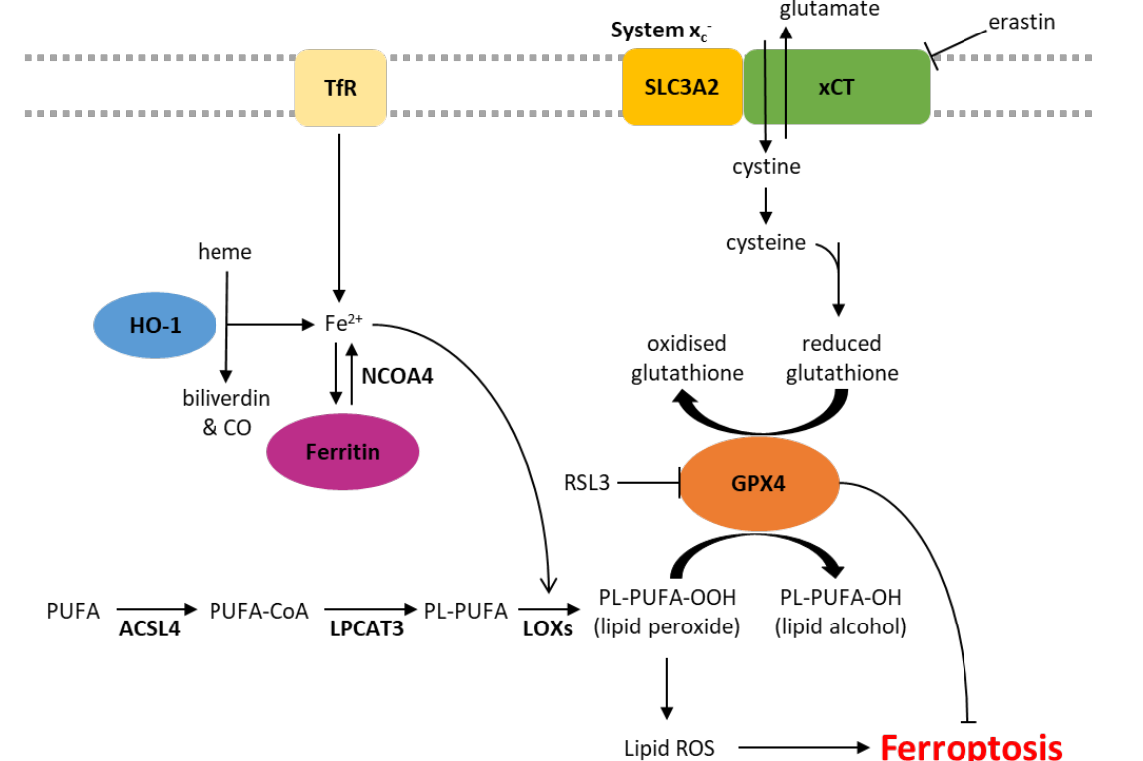
Figure 1. Biochemical pathways involved in the regulation of ferroptosis. ACSL4, acyl-CoA synthe- tase long-chain family member 4; CO, carbon monoxide; Fe 2+ , ferrous iron; GPX4, glutathione pe- roxidase 4; HO-1, heme oxygenase 1; LOXs, lipoxygenases; LPCAT3, lysophosphatidylcholine acyl- transferase 3; NCOA4, nuclear receptor coactivator 4; PL, phospholipid; PUFA, polyunsaturated fatty acid; ROS, reactive oxygen species; TfR, transferrin receptor.